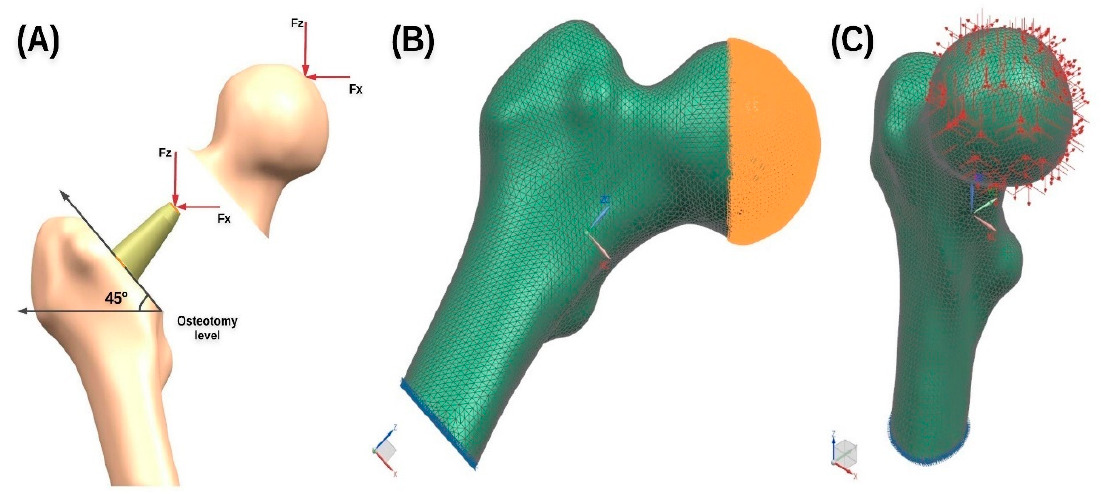
Figure 4. ( A ) Osteotomy level. ( B ) Acetabulum region where the load is applied. ( C ) Boundary